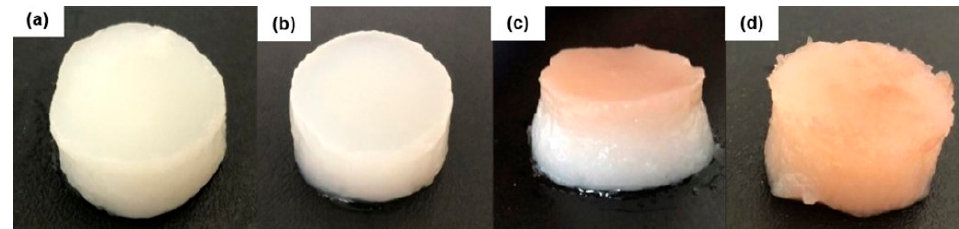
Figure 2. Photographs of the hydrogels ET ( a ), PG ( b ), BT/ET ( c ), and BT/PG ( d ).